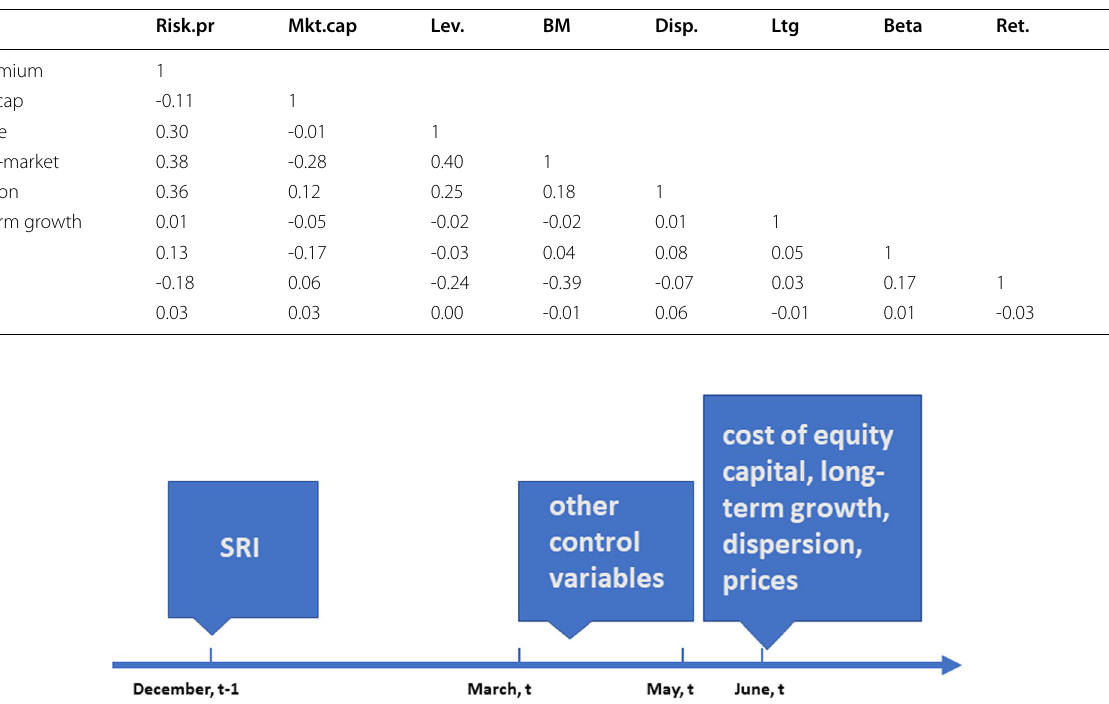
Fig. 3 Time line of SRI, cost of equity capital, and other